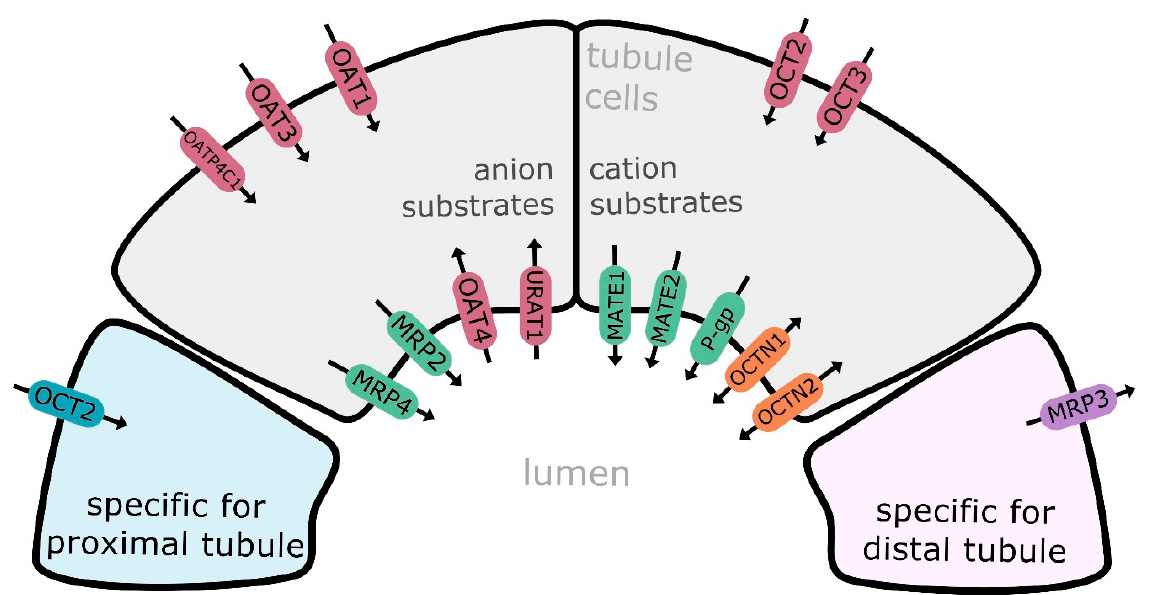
Figure 1. Major drug transporters in the kidney renal epithelial cell: MATE1—multidrug and toxin extrusion protein 1; MATE2/ SLC47A2 —multidrug and toxin extrusion protein 2; MATE2-K—multidrug and toxin extrusion protein 2 kidney-specific; MRP2—multidrug resistance-associated protein 2; MRP3—multidrug resistance-associated protein 3; MRP4—multidrug resistance-associated protein 4; P-gp—multidrug resistance protein 1/P-glycoprotein; OAT1—organic anion transporter 1; OAT3—organic anion transporter 3; OAT4—organic anion transporter 4; OATP4C1—organic anion transporting polypeptide 4C1; OCT2—organic cation transporter 2; OCT3—organic cation transporter 3; OCTN1—organic cation/carnitine transporter 1; OCTN2—organic cation/carnitine transporter 2; URAT1—urate transporter 1. Efflux transporters/carriers highlighted in green/violet, influx carriers in red/bleu and bidirectional carriers in or- ange.